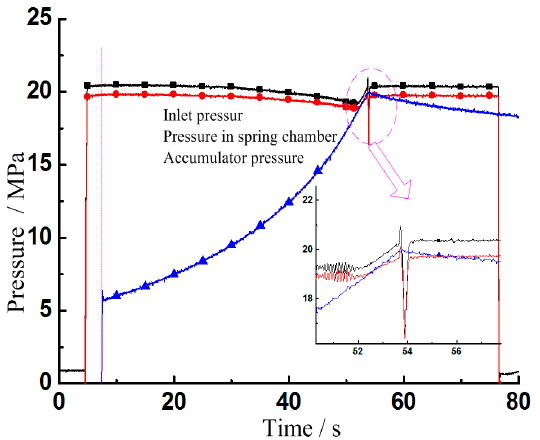
Figure 12. Pressures during the energy regeneration process.